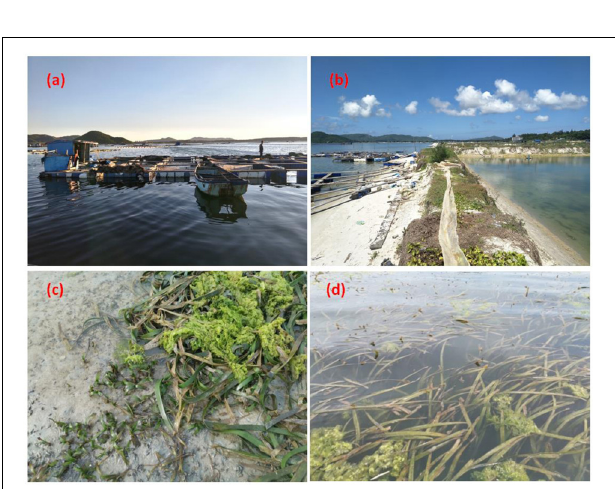
FIGURE 6 | Schematic diagram of seagrass leaves as spawning grounds and food source for marine species and Marine Protective Areas (MPAs).